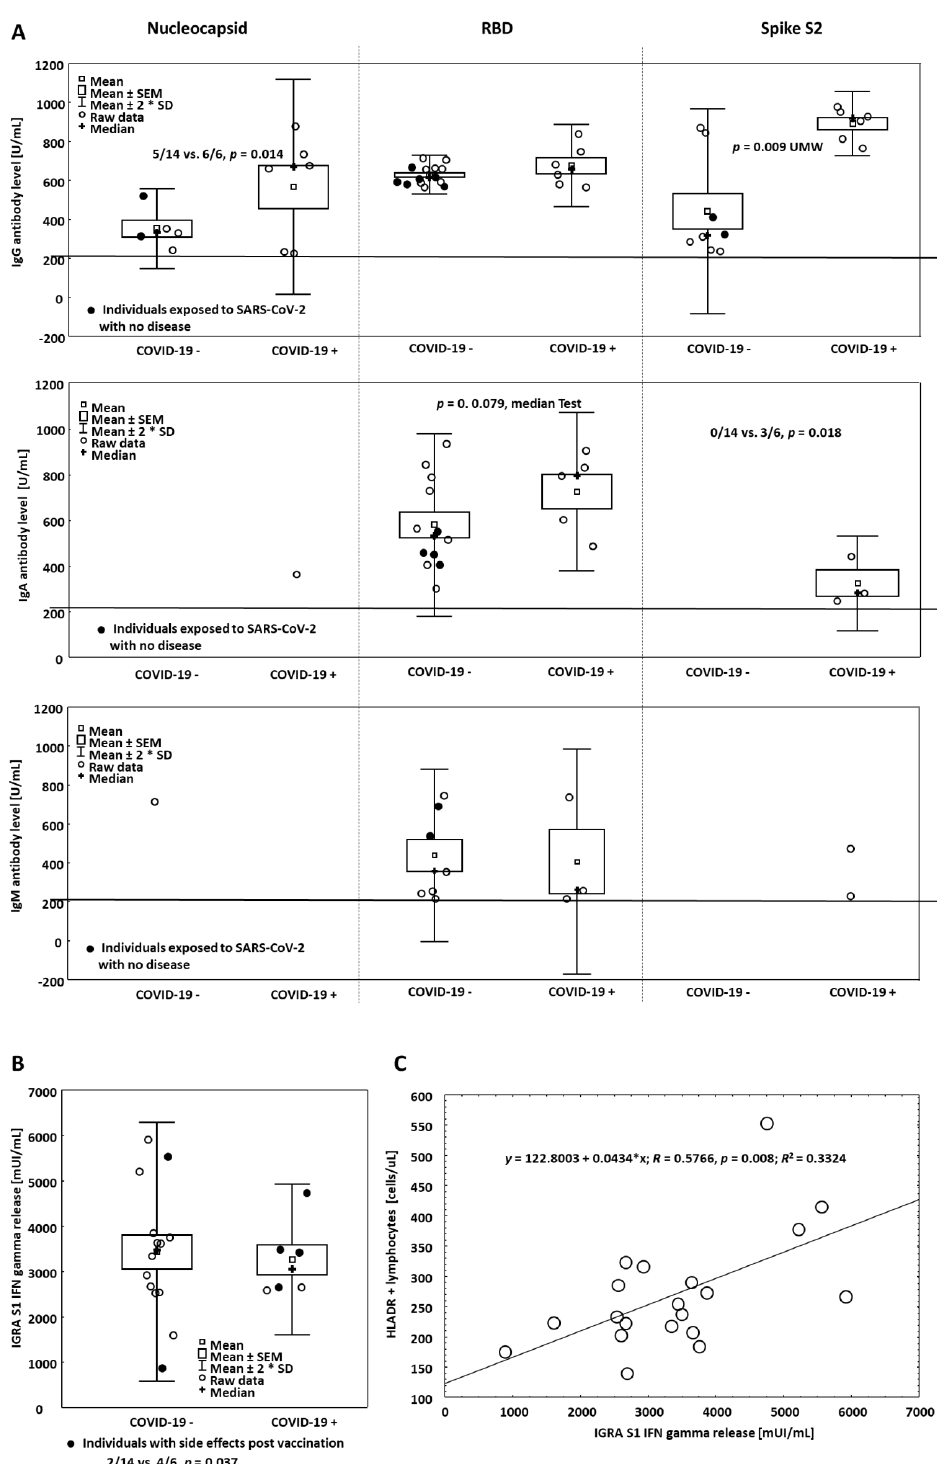
Figure 1. Panel ( A ) Levels of SARS-COV-2 antibodies after vaccination in individuals having and lacking COVID-19 past history. The horizontal line represents the threshold value of positivity (only the positive sera results are shown, metrics represent both the statistics of individual values and frequencies in the groups). Panel ( B ) IGRA results in the groups as above, closed circles indicate individuals with post-vaccination side effects. Note that the patients who had experienced the disease had side effects after vaccination more frequently than those not having COVID-19 in the past but both groups did not differ in IFN gamma response to S1 peptides. Panel ( C ) Correlation curve between IGRA results and numbers of HLADR + lymphocytes in the